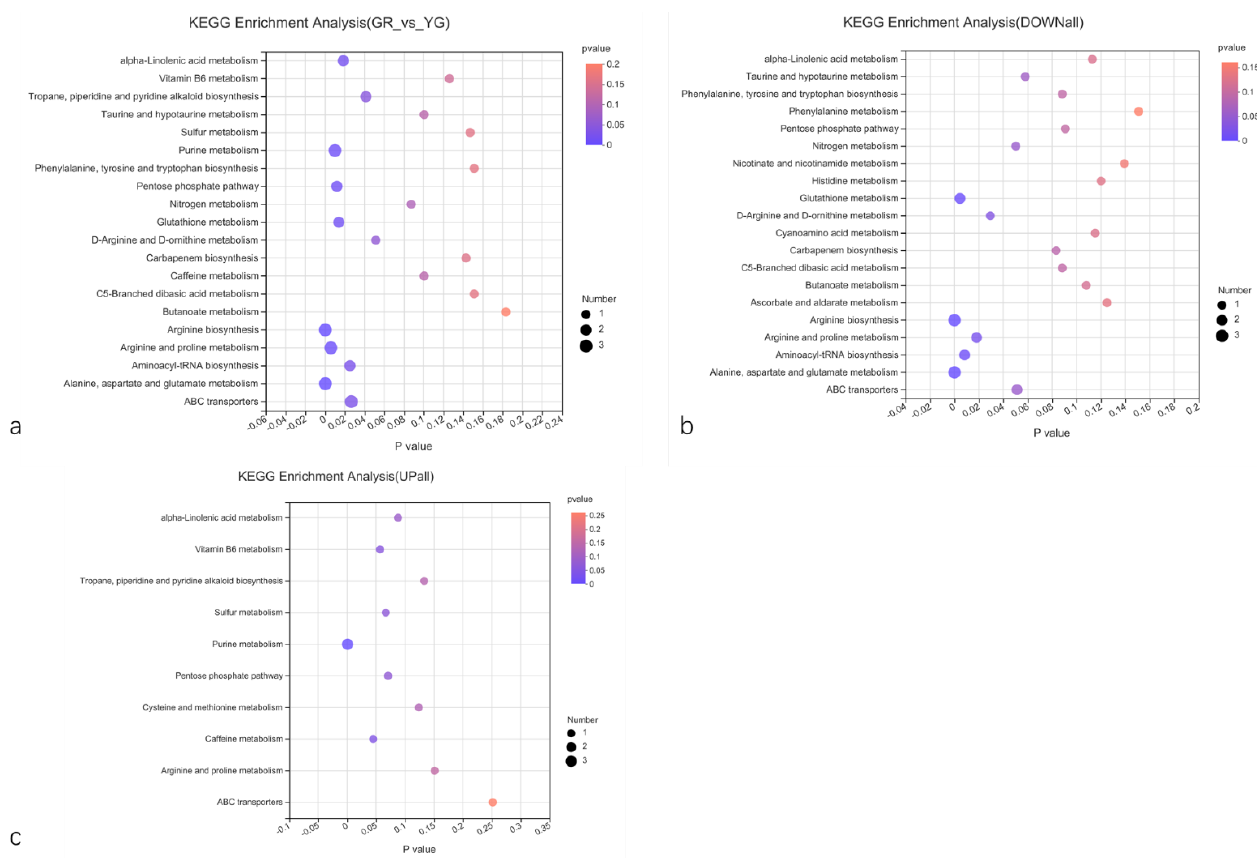
Figure 13. KEGG enrichment pathways of metabolites. ( a ) KEGG enrichment pathways of differentially accumulated metabolites. ( b ) KEGG enrichment pathways of downregulated differentially accumulated metabolites. ( c ) KEGG enrichment pathways of upregulated differentially accumulated metabolites. GR indicates the green region of the leaf, and YG indicates the yellow – green region of the leaf.